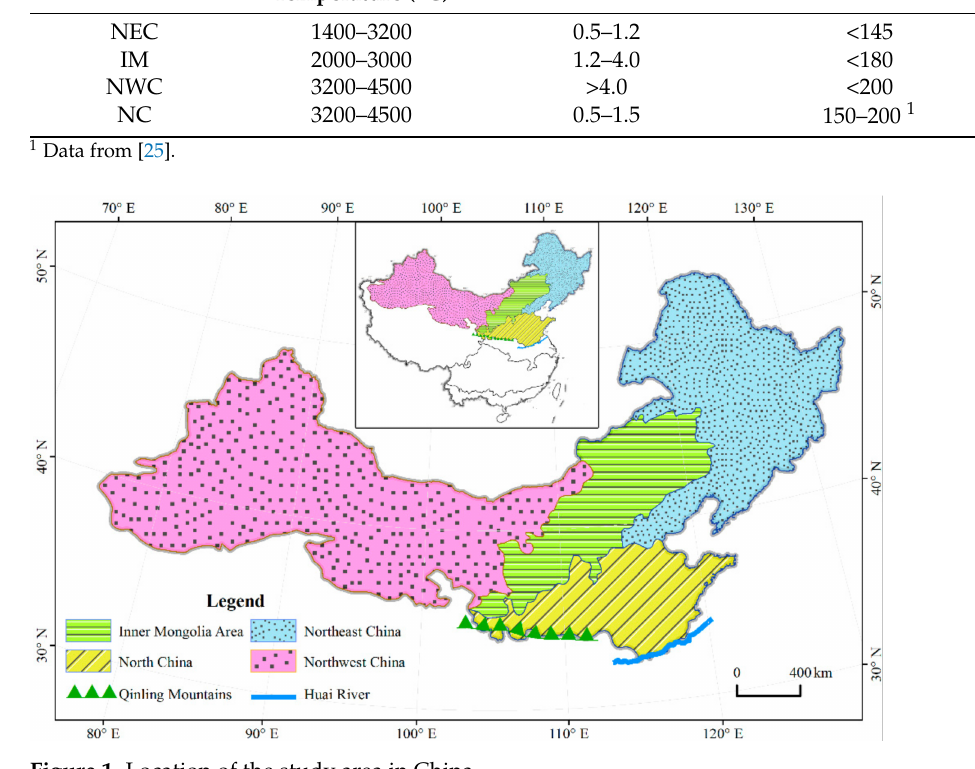
Figure 1. Location of the study area in